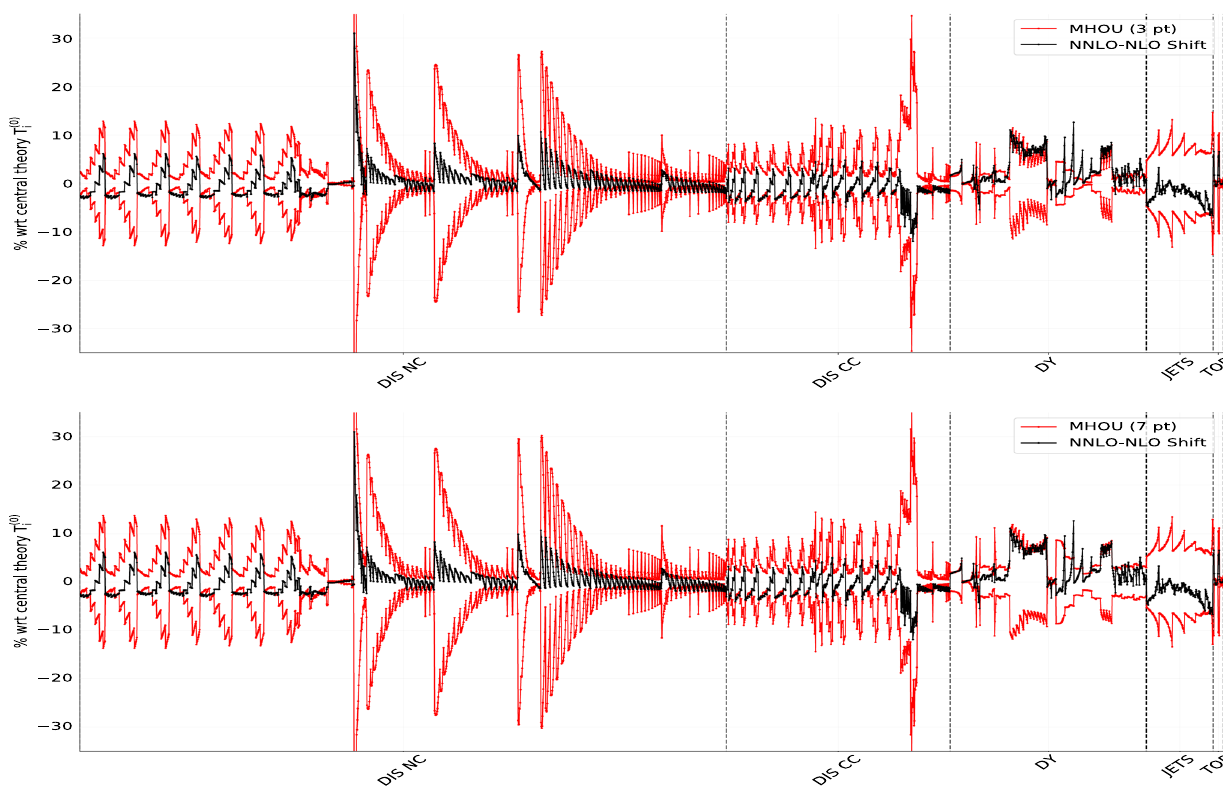
Fig. 10 Same as Fig. 9 but for the asymmetric prescriptions: 3-point (top) and 7-point (bottom)